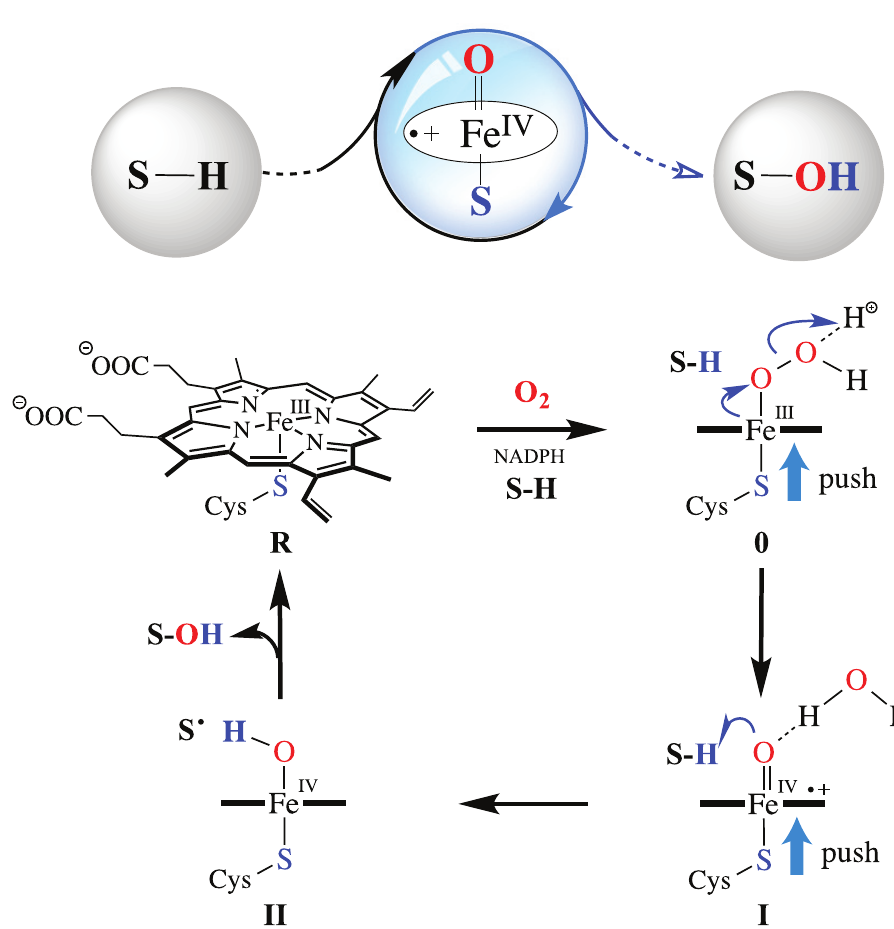
Figure 2. Cytochrome P450 hydroxylation mechanism. The reaction cycle proceeds clockwise from the upper left. In the resting form of P450 (R), the iron in the heme-thiolate active site is in the ferric (Fe III ) oxidation state. Upon binding of the substrate molecule (S-H), molecular oxygen is bound and reduced to a coordinated hydroperoxide (0). A proton relayed from a glutamic acid through a chain of water molecules facilitates cleavage of the peroxide O-O bond (blue arrows). One role of the cysteine sulfur ligation is thought to be electron donation (push) that weakens the O-O bond. The result of peroxide O-O bond scission is to produce a stable water molecule and a highly reactive and strongly oxidizing intermediate (I). Spectroscopic evidence supports an oxo-iron(IV) porphyrin radical cation formulation for I, which is the species responsible for cleaving even very strong substrate C-H bonds. This C-H bond scission is a one-electron process wherein the substrate proton is transferred to the ferryl oxygen (Fe=O) of I to produce II and a substrate-derived radical (S•). Dual roles for the cysteine sulfur in this process are increasing the basicity of the ferryl oxygen that receives the proton while reducing the redox potential of the iron(IV) porphyrin radical cation in I. Finally, collapse of this ensemble [S• HO-Fe IV -S-Cys] affords the hydroxylated product (S-OH) and the resting enzyme R to complete the